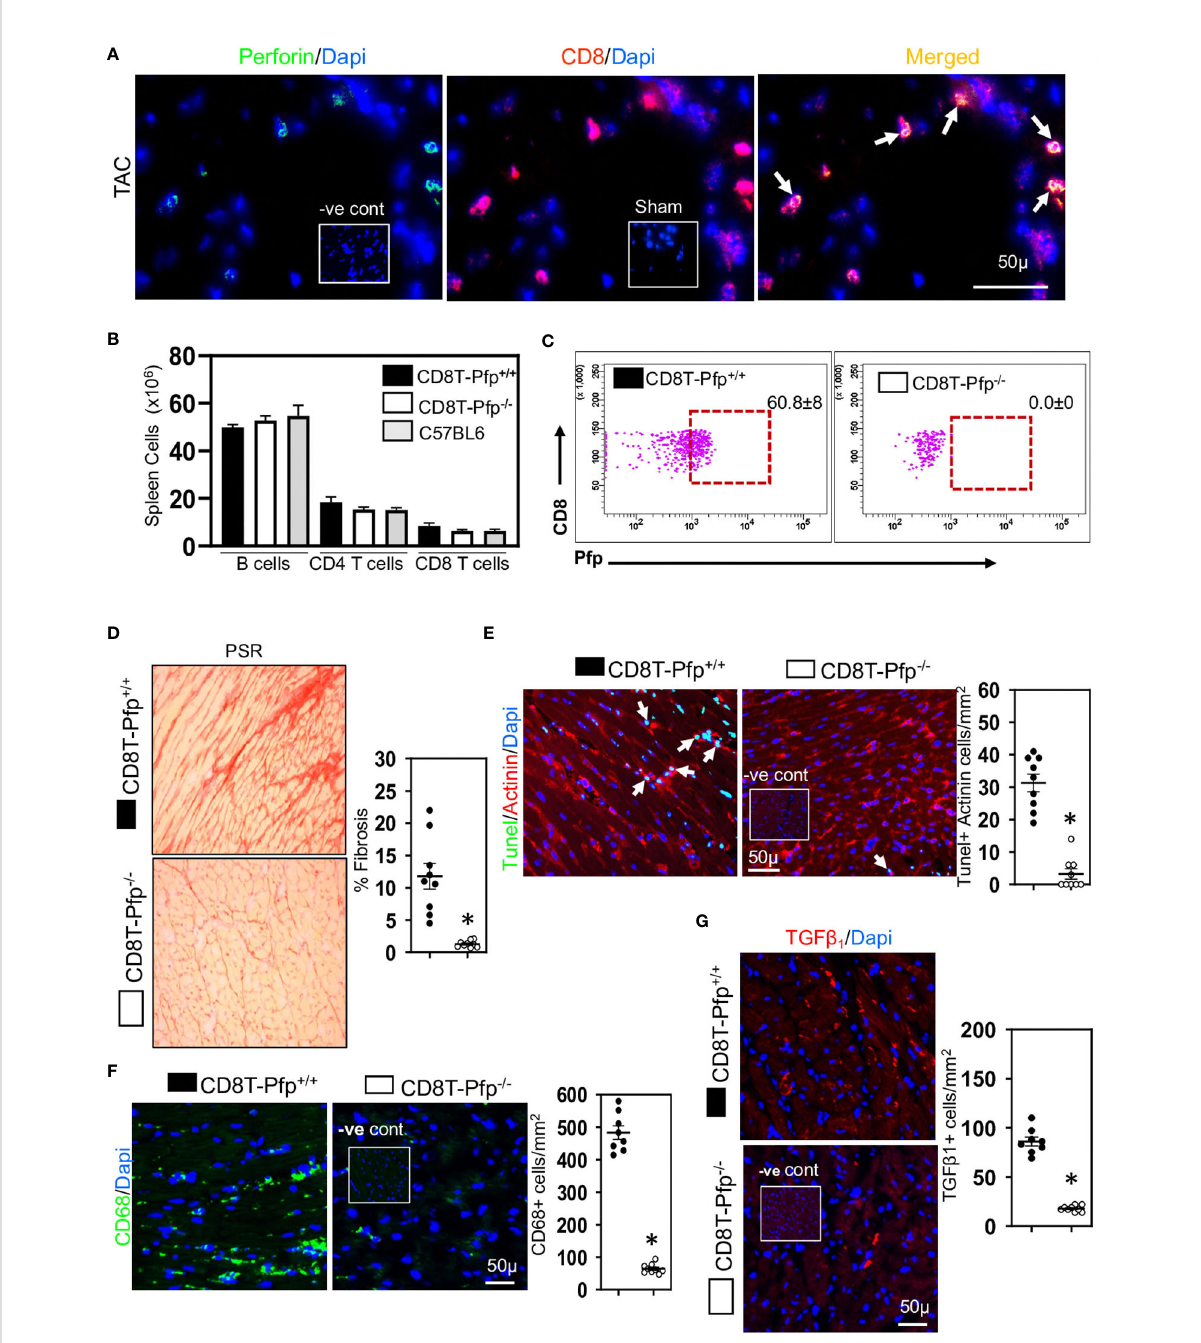
FIGURE 3 Cardiac CD8+ T cells require perforin to promote fi brosis. (A) Representative photomicrographs indicating perforin expression by CD8+ T cells in fi brotic ventricle of TAC mice. (B) Bar graphs indicating that 4-weeks after bone marrow transplantation major lymphocyte populations have recovered to levels seen in non-irradiated C57BL/6 mice. (C) Representative FACS plots indicating that spleen CD8+ T cells in CD8T-Pfp -/- mice are de fi cient in perforin 4 weeks after BMT compared to CD8T-Pfpf +/+ mice. (D) Photomicrographs (PSR) together with mean data indicating that perforin deletion in CD8+ T cells attenuates fi brosis in LV of TAC mice compared to controls. (E) Photomicrographs indicating that TUNEL +Actinin+ cardiomyocytes are greatly reduced in mice with perforin de fi cient CD8+ T cells. (F) LV CD68+ macrophages and (G) TGF- b 1 expressing cells are greatly reduced with perforin deletion from CD8+ T cells. Results are means ± SEM with small circles representing data from individual mice. n=5-9/group. PSR; picrosirius, -ve control; no primary antibody control, sham; sham-operated, scale bar represents 50µm. *P< 0.05 using two-tailed Student ’ s t-test comparing to CD8T-Pfp +/+